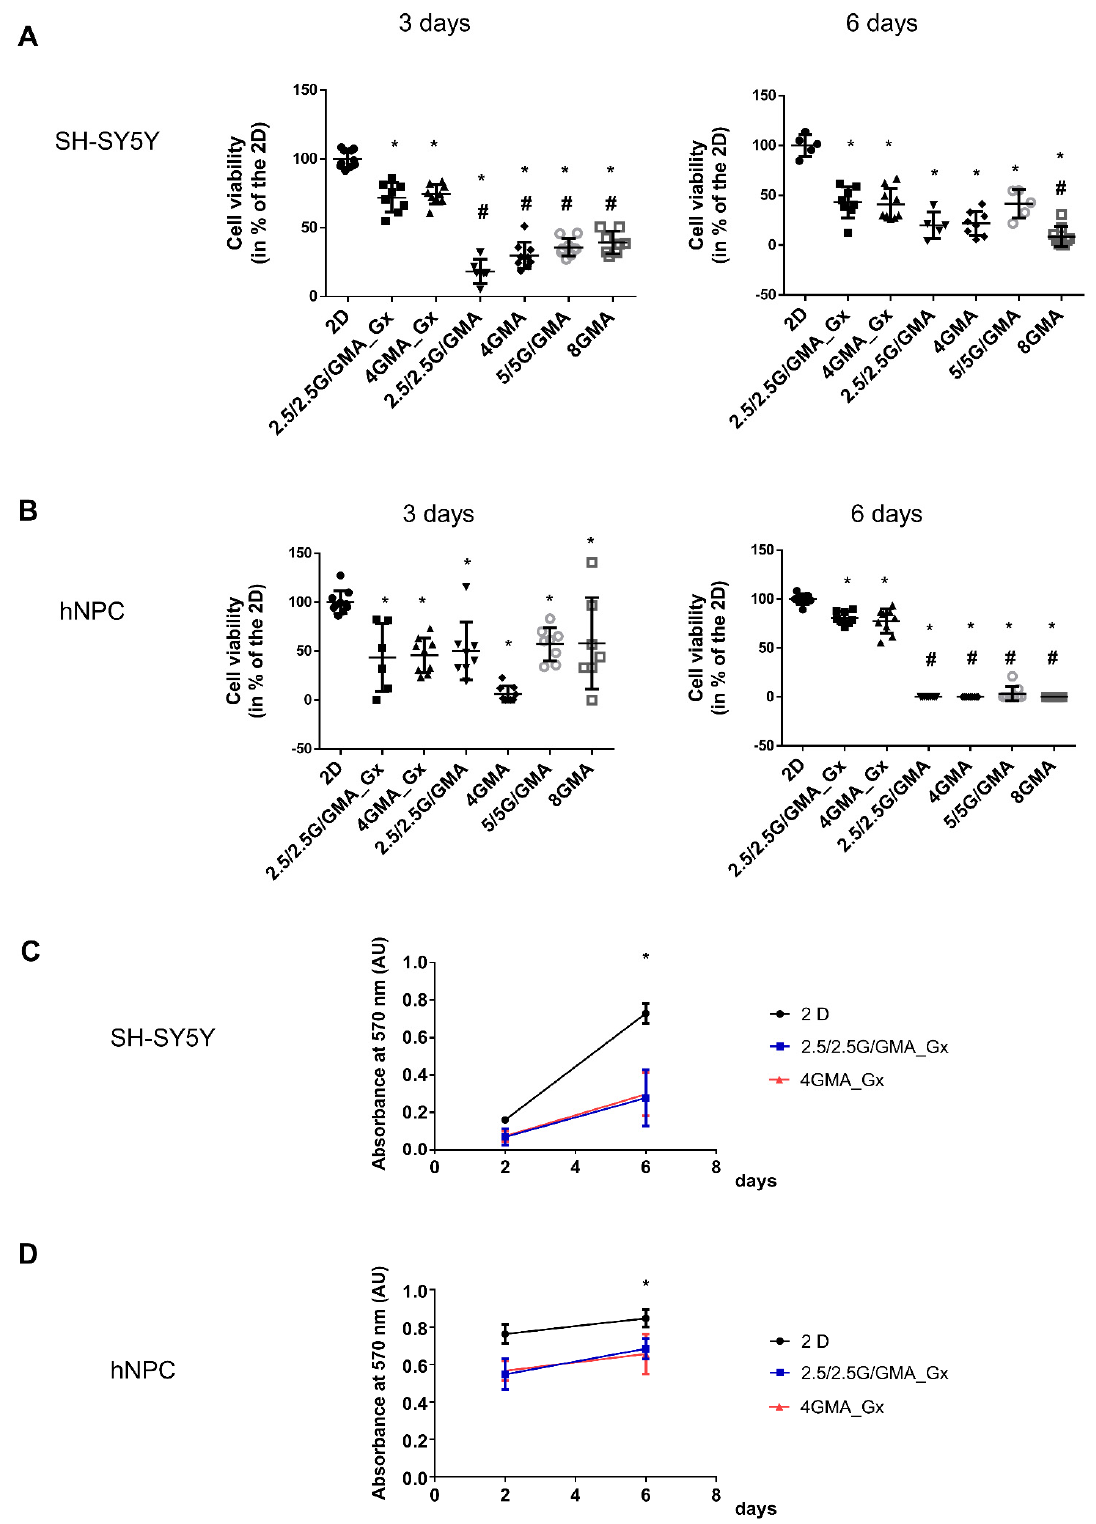
Figure 3. The addition of Geltrex TM to the bioink is essential for maintaining hNPCs. The viability SH-SY5Y in all bioinks tested was below 2D viability. On the sixth day, viability in all bioinks remained below 2D viability. Geltrex TM addition to the bioink slightly increased the mean viability, but it was only statistically higher in comparison to the 8GMA group ( A ). For hNPCs, on the third day, there was a significant decrease in cell viability in all groups compared to the 2D and the Geltrex TM